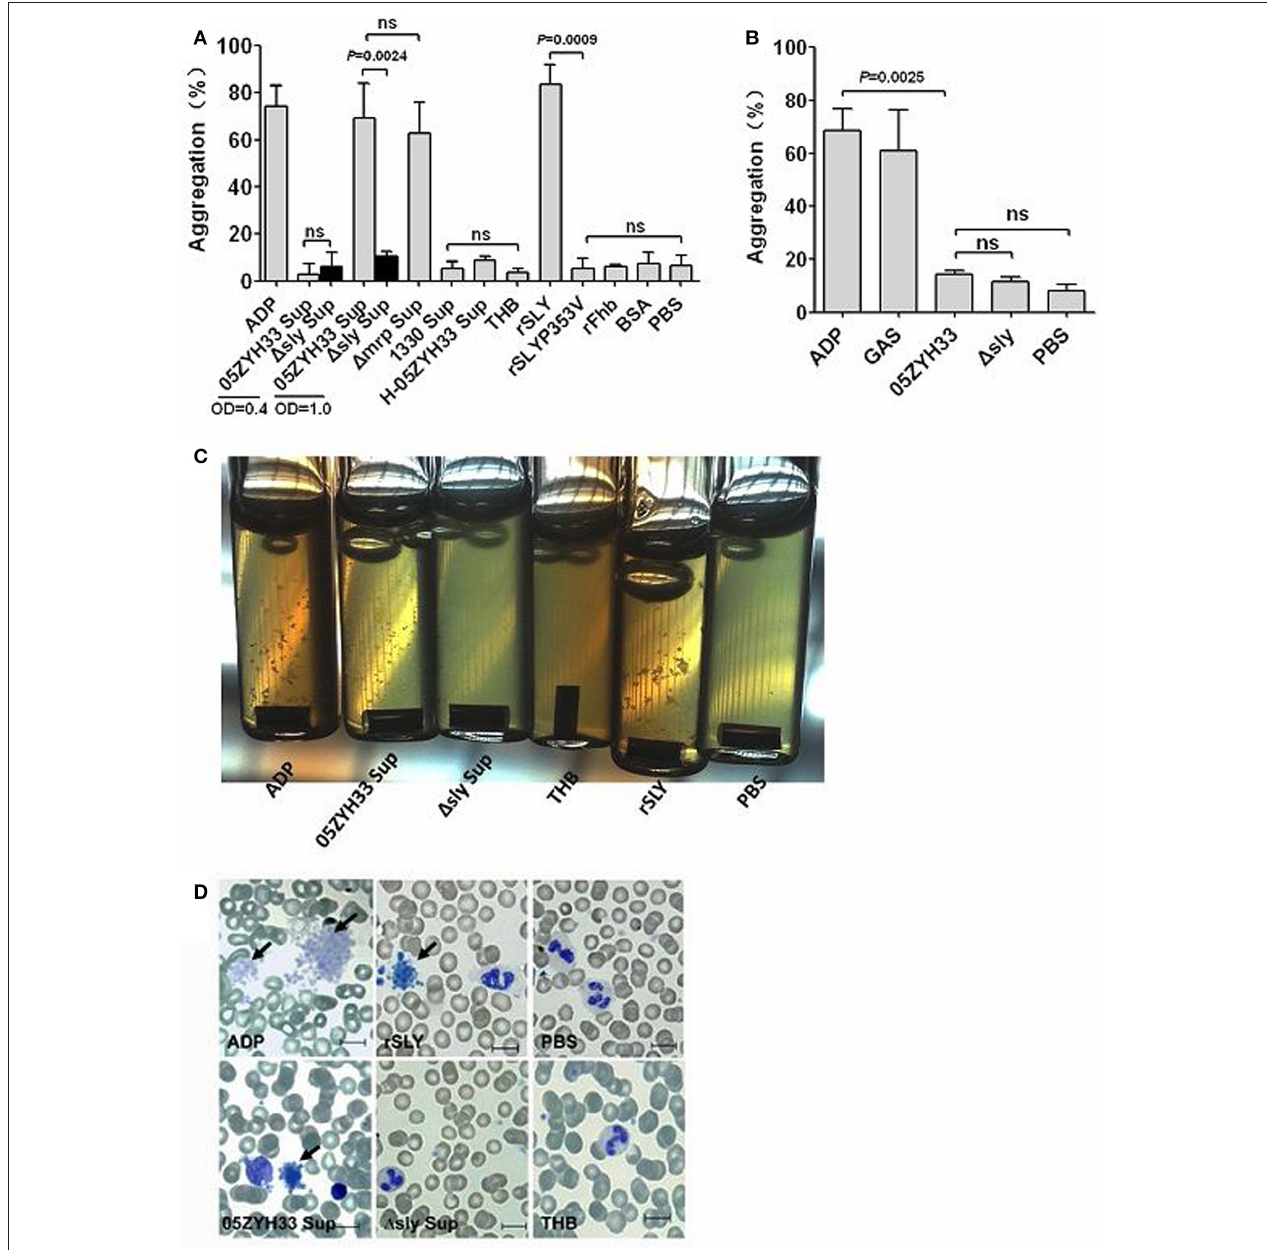
FIGURE 1 | SLY is the sole stimulus of S. suis -induced platelet aggregation. (A) The culture supernatant of S. suis and recombinant proteins or (B) the washed bacteria cells were added to PRP in a stirred cuvette. Platelet aggregation was expressed as a final percentage of light transmission detected by Platelet Aggregometer se-2000. ADP (20 µ M) and GAS bacterial cells were used as the positive controls. Unpaired two-tailed Student’s t -tests were used and the threshold for significance was P < 0.05; ns, not significant. Data are expressed as the mean ± SD of three independent experiments, with each experiment using blood from a different donor. (C) Platelet aggregations were observed when detecting the light transmission of PRP stimulated by bacterial supernatant (at OD 600 = 1.0) or rSLY. (D) Wright’s staining of cytospin preparations of S. suis culture supernatant or rSLY protein-treated whole blood samples. 05ZYH33, wild type strain; 1 sly, isogenic mutant of sly; 1 mrp, isogenic mutant of mrp (which was used as an irrelevant control for 1 sly); 1330, SLY-negative Canadian strain; H-05ZYH33, heat-inactive 05ZYH33; Sup, supernatant; rSLY, recombinant SLY; rSLY P353V , recombinant non-hemolytic mutant of SLY P353V ; rFhb, recombinant Factor H-binding protein, which was used as an irrelevant protein and was purified by the same procedure as that used for